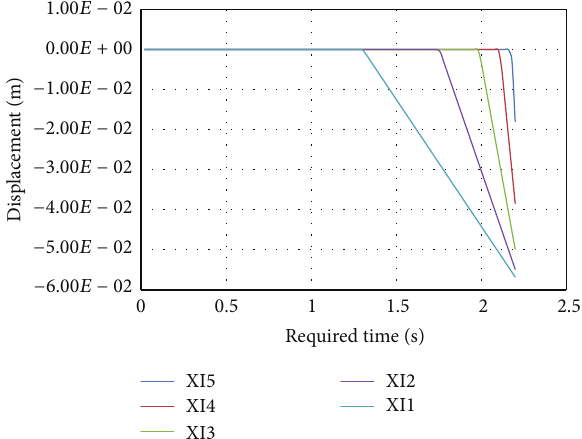
Figure 16: Movement of each blood clot part.